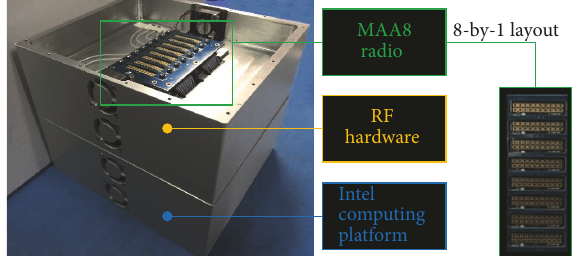
Figure 2: Integrated 60 GHz mmWave MAA architectures and